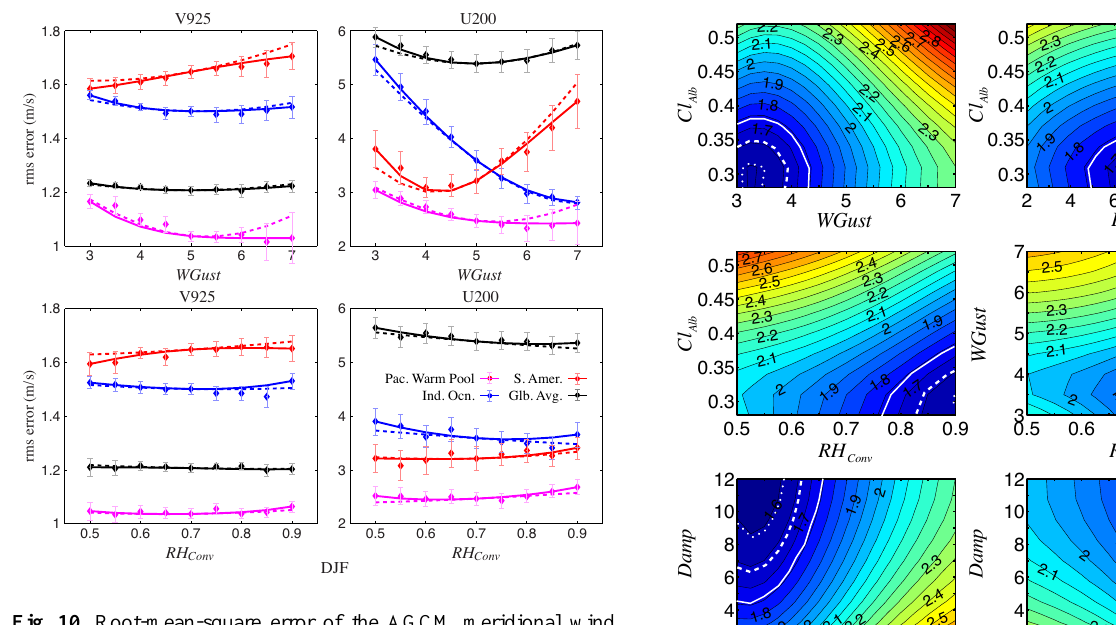
Fig. 10. Root-mean-square error of the AGCM meridional wind at 925hPa (left) and zonal wind at 200hPa (right) climatology in December–February for target regions relative to the National Cen- ters for Environmental Prediction reanalysis. The AGCM values are compared to the quadratic metamodel reconstruction based on the endpoints for each parameter, and to its linear counterpart. Global average in black, Pacific Warm Pool in magenta, Indian Ocean basin in blue and South America in red. Units on abscissa are ms − 1 for WGust (top panels) and nondimensional for RH Conv (bottom pan- els). Error bars quantify the spread of the error within the ten en- semble members ( ± 1 standard error of the ensemble).